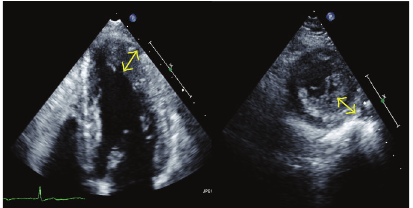
Figure 3: Two-dimensional echocardiography. Hypertrophy of the apical lateral wall was observed inthe apical four chamber view(left) and short axis view